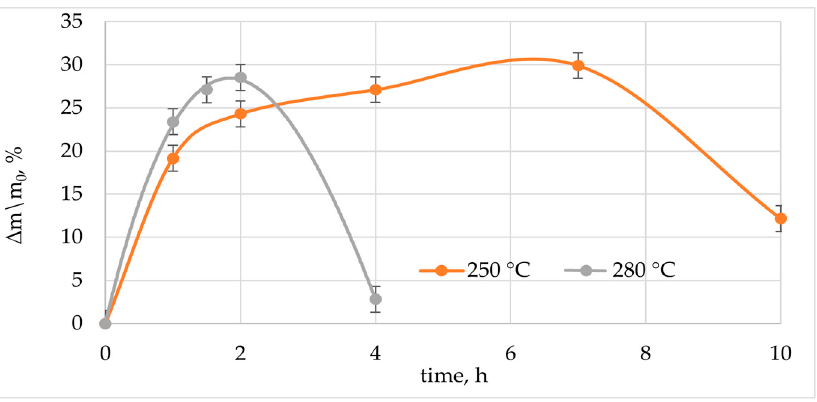
Figure 2. The curve of the relative mass ratio with time depending on the temperature of solvolysis.